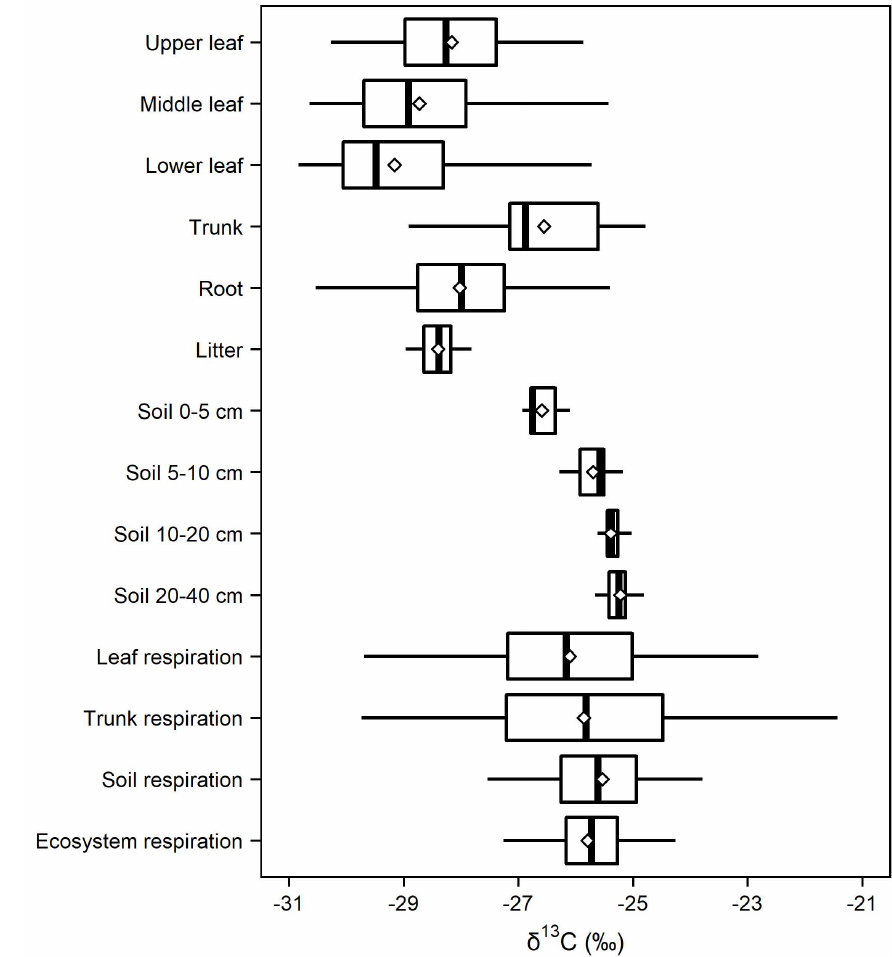
Figure 5. A comparison of the C isotopic composition of ecosystem organic pools and respiratory fluxes. Diamonds represent the means. The box represents the median and the 25% upper / lower quartiles. The tails represent the 10% and 90% limits of the data. Leaf samples were taken once a month from May to September 2019. The trunk values are the average of the bark and xylem, the root values are the average of the coarse and fine roots, and the litter values are the average of the undecomposed layer (Oi) and the decomposed layer (Oe + Oa). These samples, along with the soil samples, were sampled at the end of September 2019. The leaf, trunk, and soil δ 13 C R were measured 15 times from May to September 2019. δ 13 C eco was determined at a daily scale from May to September